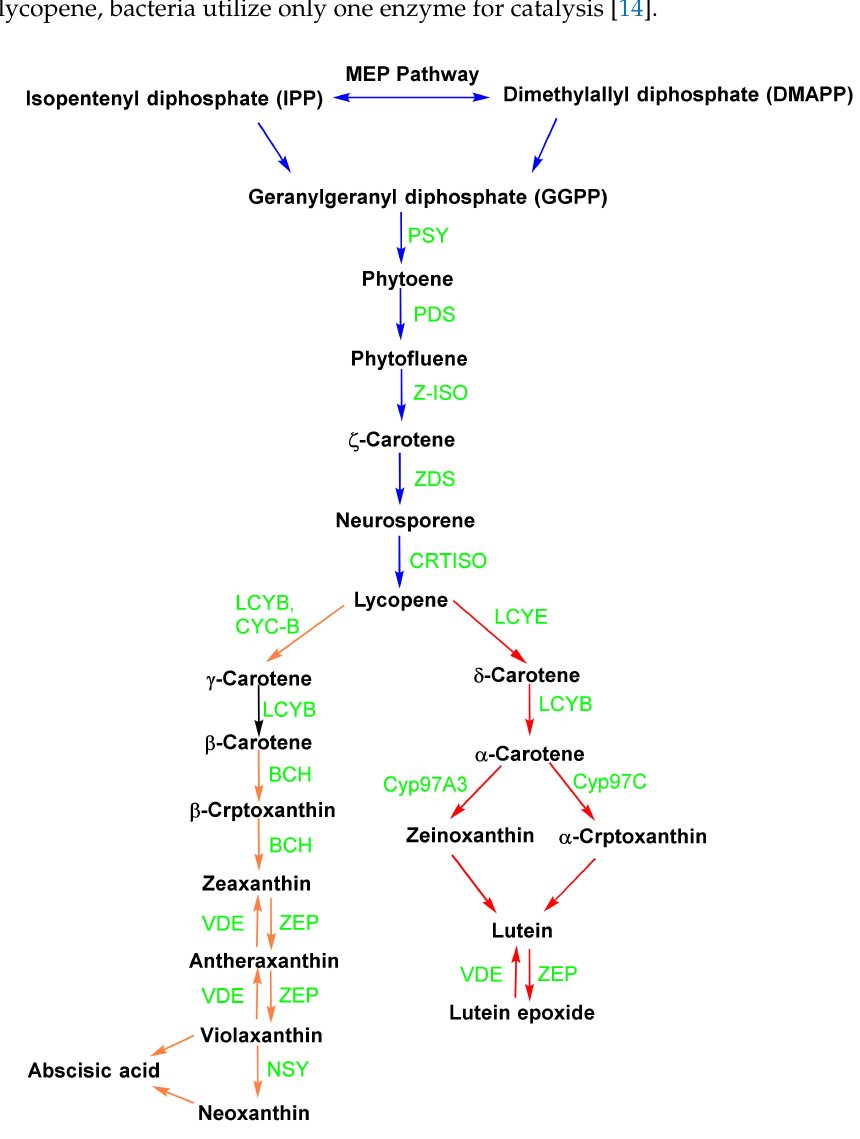
Figure 2. The carotenoid biosynthetic pathway in plants. PSY: phytoene synthase; PDS: phytoene desaturase; Z-ISO: ζ -carotene isomerase; ZDS: ζ -carotene desaturase; CRTISO: carotene isomerase; LCYE: lycopene ε -cyclase; LCYB: lycopene β -cyclase; CYC-B: chromoplast-specific lycopene β - cyclase; BCH: β -carotene hydroxylase; ZEP: Zeaxanthin epoxide; VDE: violaxanthin epoxide; NSY: neoxanthin synthase; CYP97A3: cytochrome P450-type β -hydroxylase; and CYP97C1: